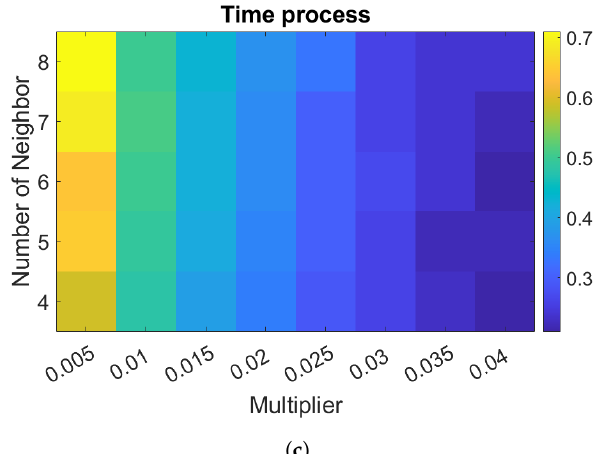
Figure 5. Simulation of the influence of the parameters in the filter on the result. ( a ) Effect of multiplier and NoN on accuracy. ( b ) Effect of multiplier and NoN on F1-score. ( c ) Effect of multiplier and NoN on execution time.